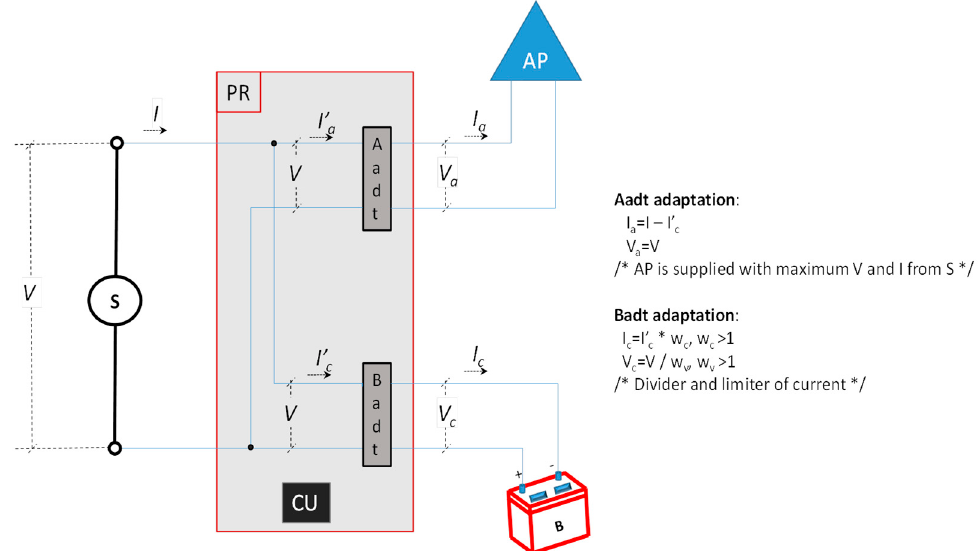
Figure 3. Graphic and formal model of our system with our mechanism working in the charge period.